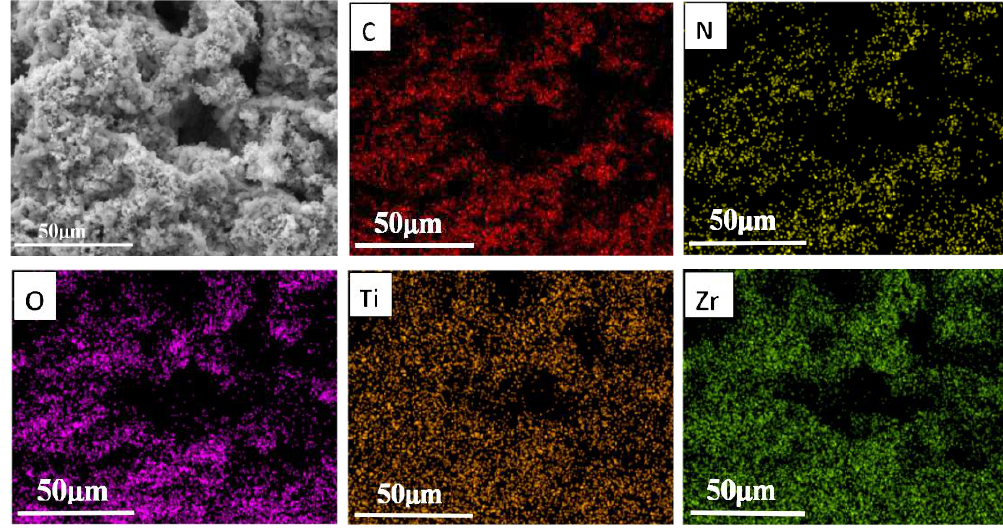
Figure 3. The element mapping images of the PPA-50.